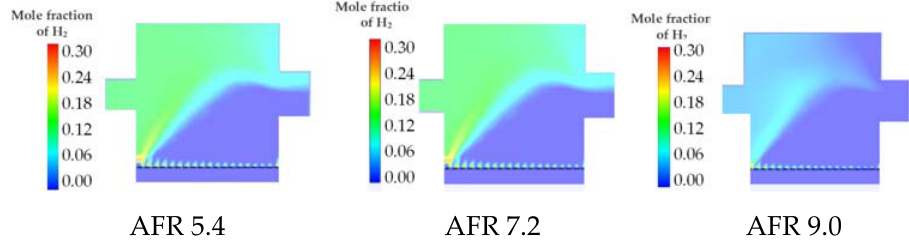
Figure 15. Contours of H 2 concentration. Table 4. Biomass pellet combustion gas components.